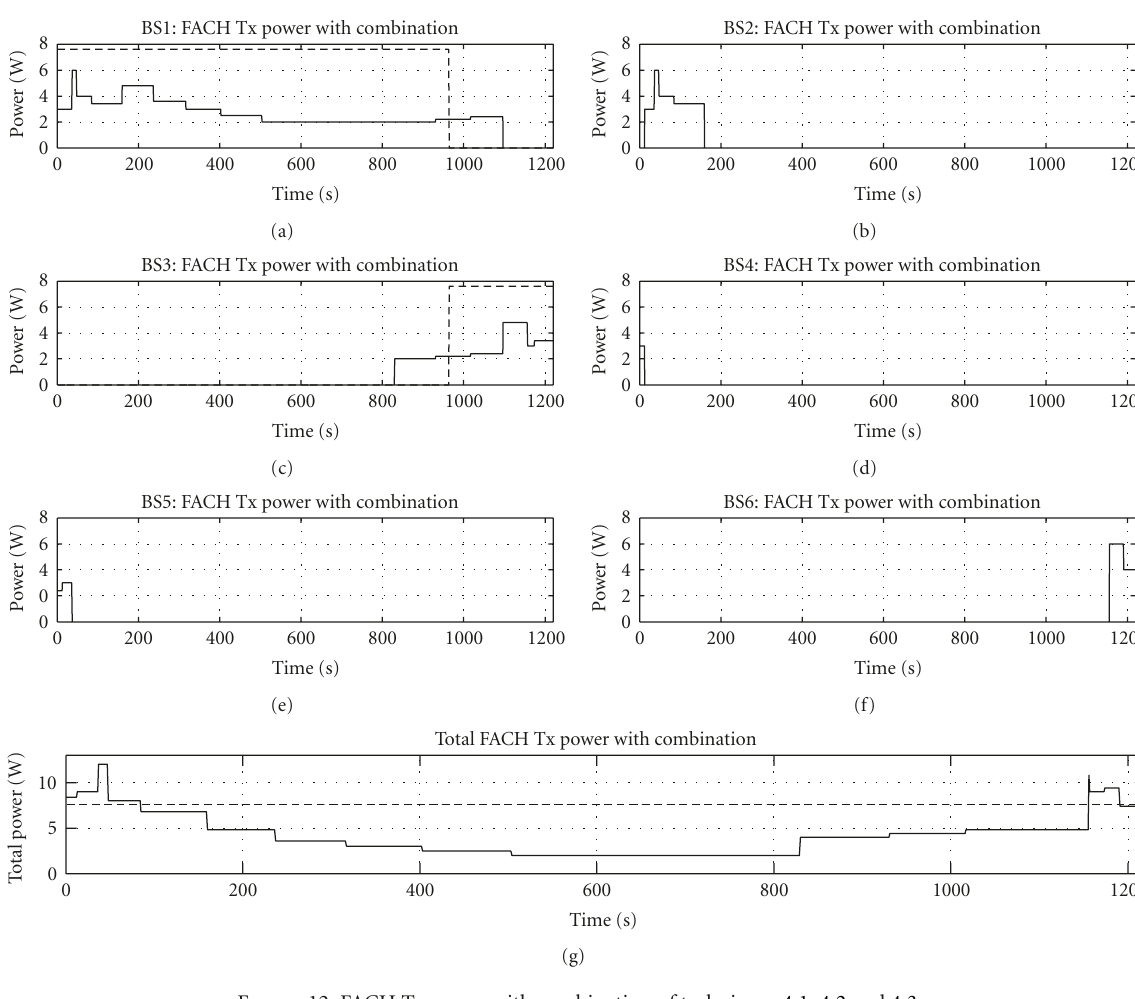
Figure 12: FACH Tx power with combination of techniques 4.1, 4.2 and